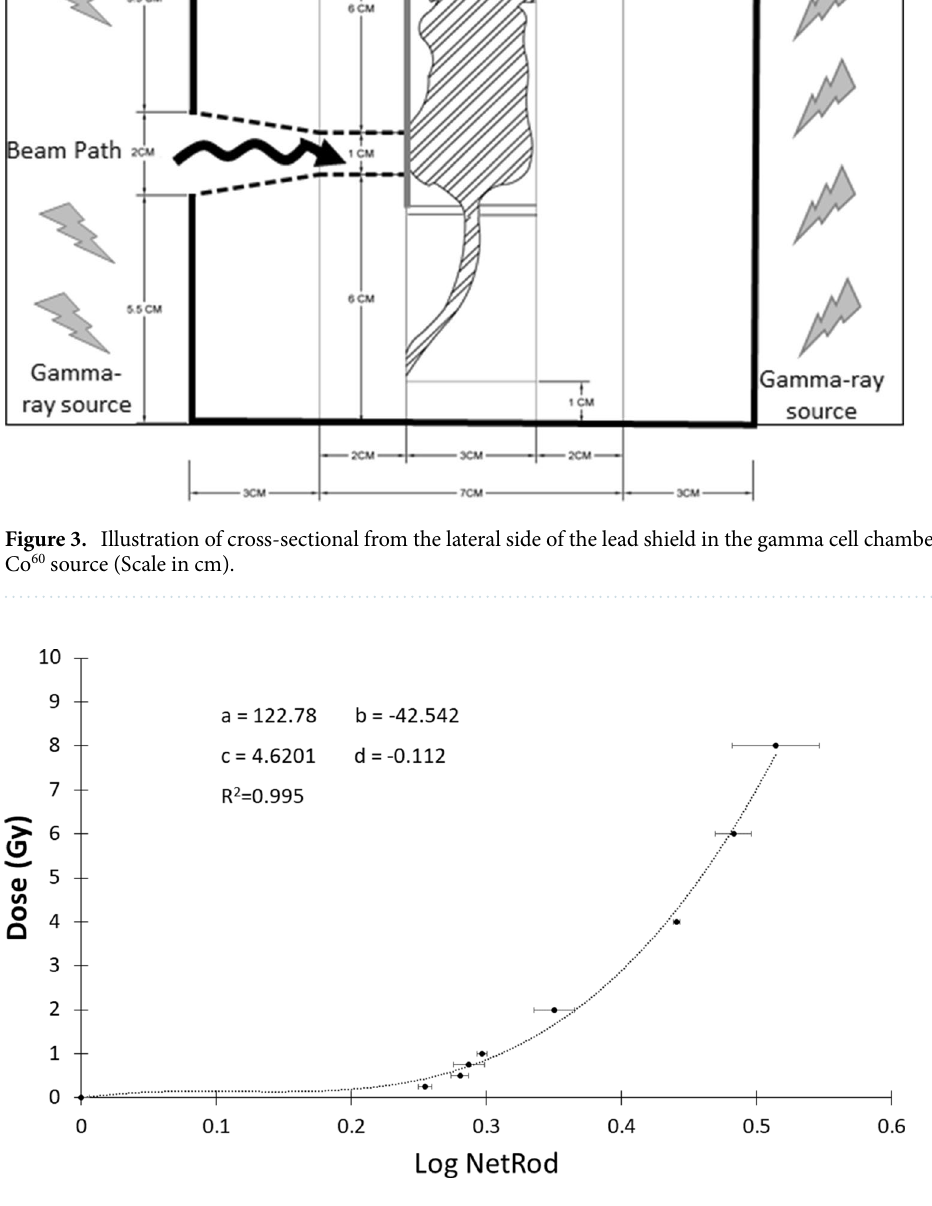
Figure 4. The calibration curve of gamma cell dose using polynomial power of 3. (Data n = 2, mean ± standard deviation). The calibration curve equation obtained is y = 122.78x 3 + (− 42.542) x 2 + 4.6201 + (−